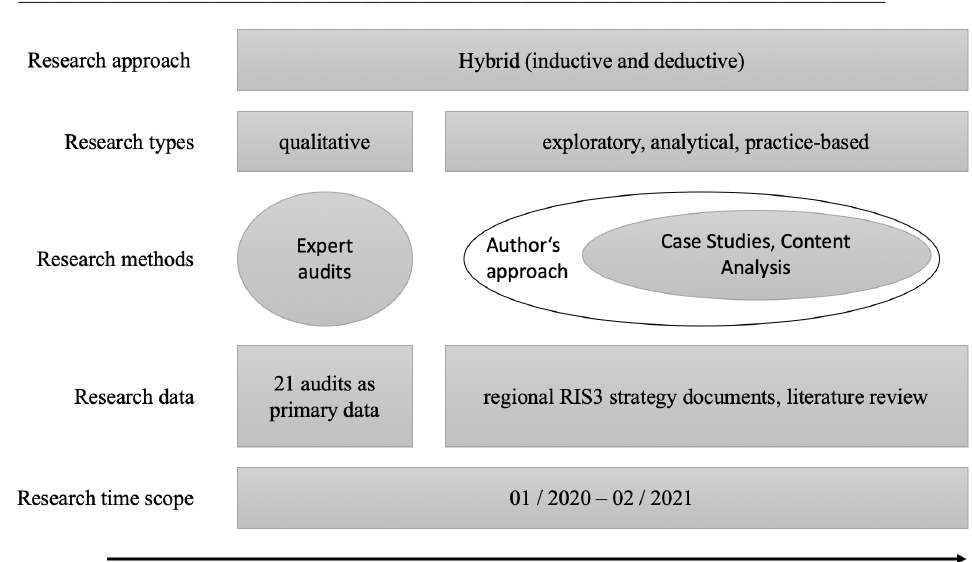
Fig. 1. Research methodology (compiled by